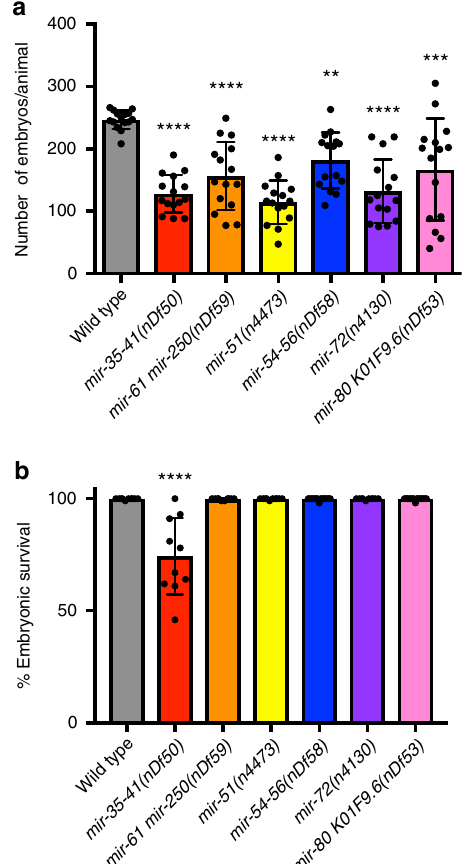
Fig. 5 Oocyte-expressed miRNAs regulate fertility. a Bar graphs represent number of embryos laid per animal over the course of its life time. Wild- type animals generate ~250 embryos at 20 °C, each of the miRNA mutants generated 100 – 150 embryos. Each experiment was repeated three times, and each time fi ve animals were counted for their number of progenies. Statistical signi fi cance was calculated with one-way ANOVA with the Bonferroni ’ s correction. **** P < 0.0001, * *P < 0.01. ± SD. b Bar graphs represent the percent of embryos that hatch and develop into larvae. Embryos from mir-35 – 41 mutants display reduced embryonic survival. Each experiment was repeated three times, and each time fi ve animals were counted for any embryonic lethality of their progeny. All the embryos deposited on the plate by each mutant were assayed for development to larval stages. Lack of development to larval stage was scored as embryonic lethality. Statistical signi fi cance was calculated by one-way ANOVA with the Bonferroni ’ s correction. **** P < 0.0001. ± (Figs. 3f and 4f, g). These data suggest that mir-54 – 56 regulates oocyte development. Based on the expression pattern of Pattern 3 and 4 miRNAs, we also wondered whether the mutant hermaphroditic animals display any meiotic maturation defects.